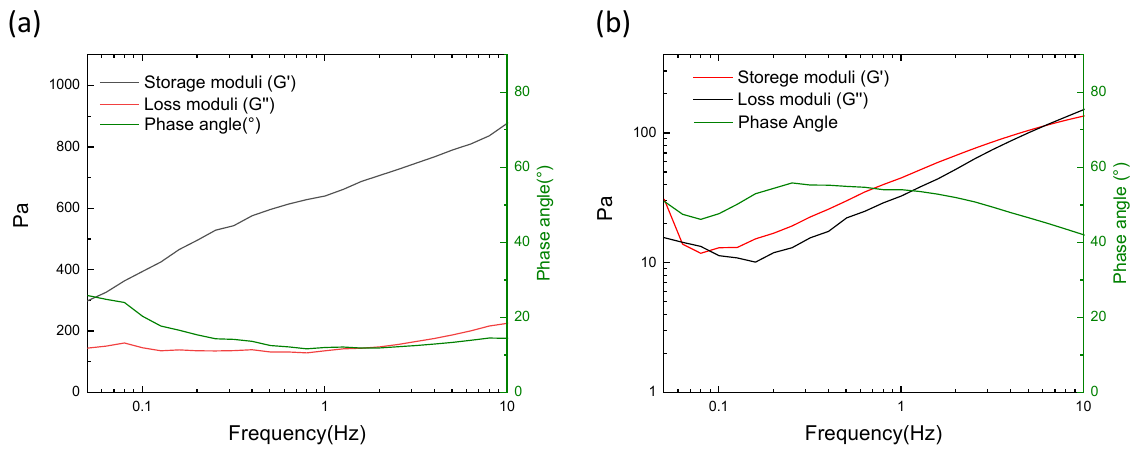
Figure 5. Rheological features of ( a ) CMC-0 h crosslinked hydrogel and ( b ) CMC-1 h hydrogel.